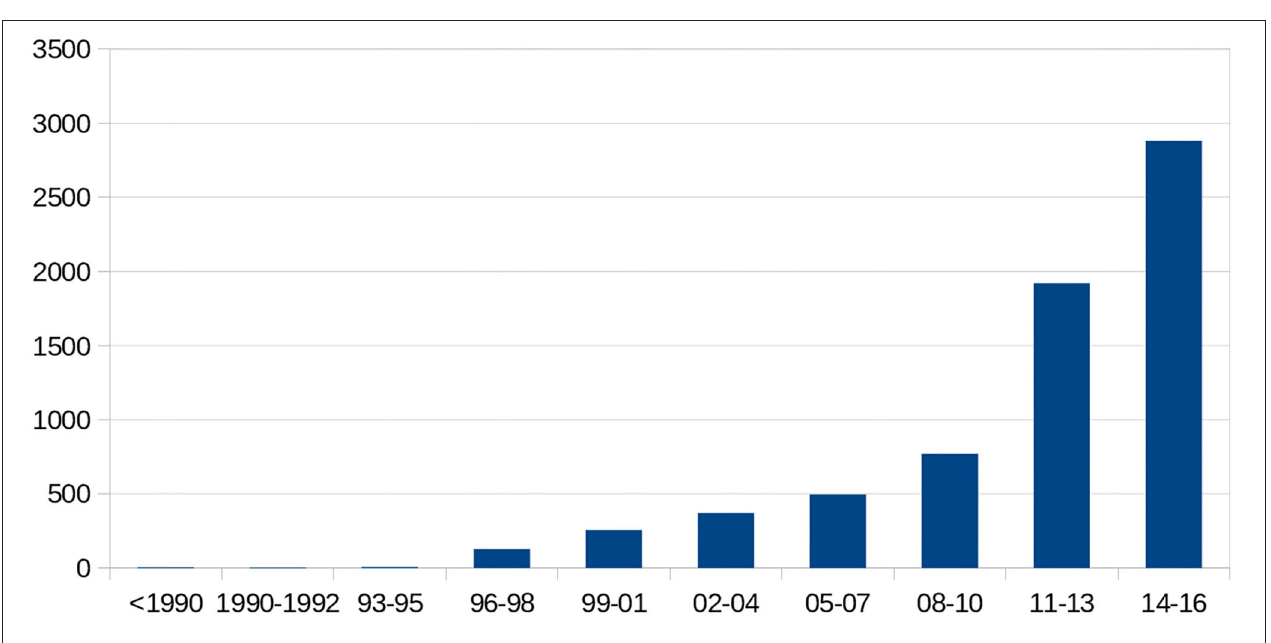
FIGURE 3 | Temporal number of transfused packed red blood